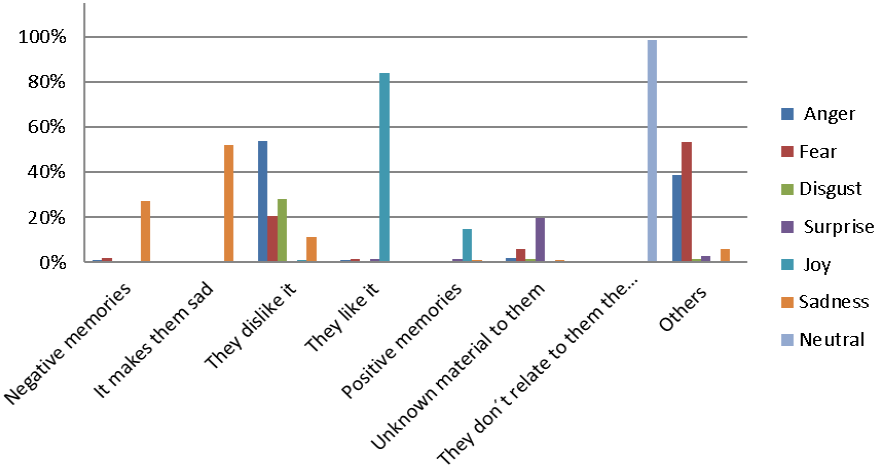
Figure 2. Emotions produced by materials in the elderly (Own production).